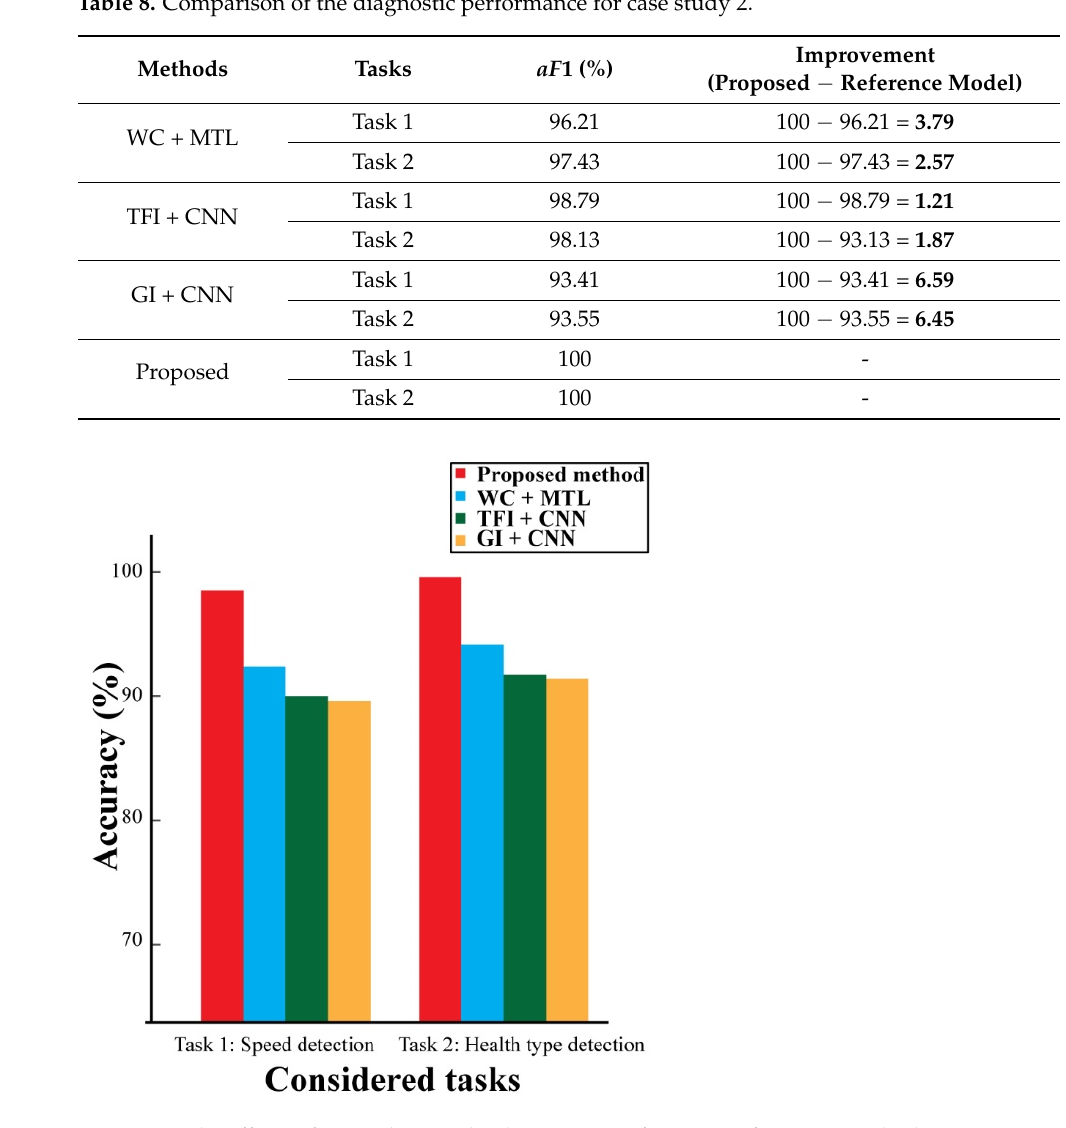
Figure 13. The effects of noisy data on the diagnostic performance of various methods.